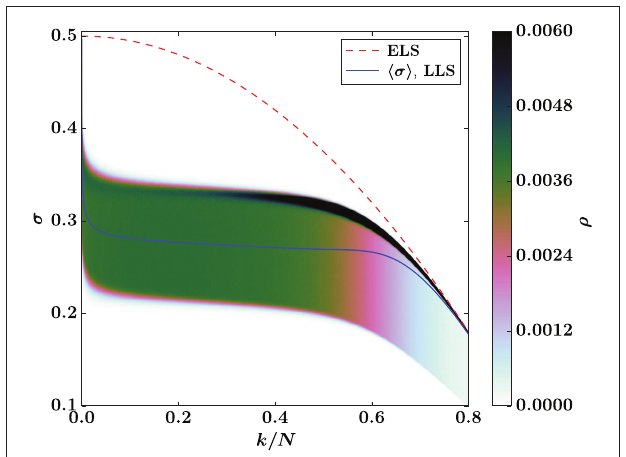
FIGURE 3 | Load curves for the ELS and LLS models with a uniform threshold distribution on [0.5,1), Equation (7) with t 0 = 1 / 2. The ELS curve is Equation (3), whereas the LLS curve is a sample average from simulations on a square lattice ( N = 128 2 ). The background is a color map that shows the density ρ of single sample LLS load curves for the 1.5 × 10 5 samples that the average is based on. The color bar is capped at ρ = 0.006 to highlight the fluctuations with the smallest values of σ .